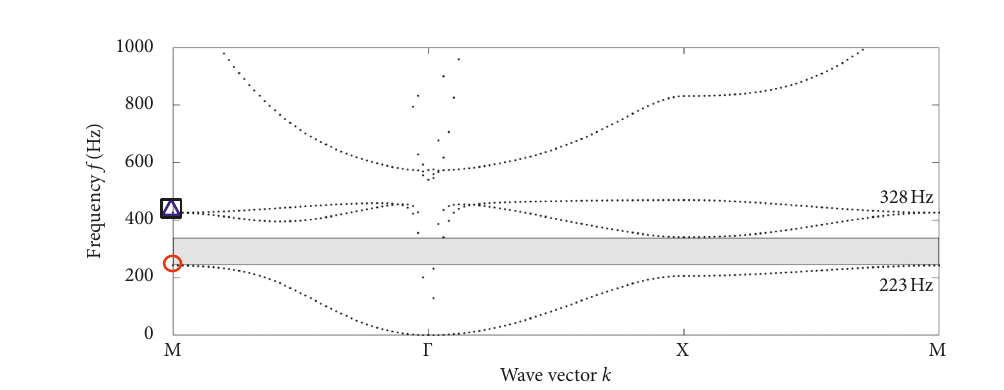
Figure 7: Dispersion curve under type 1.